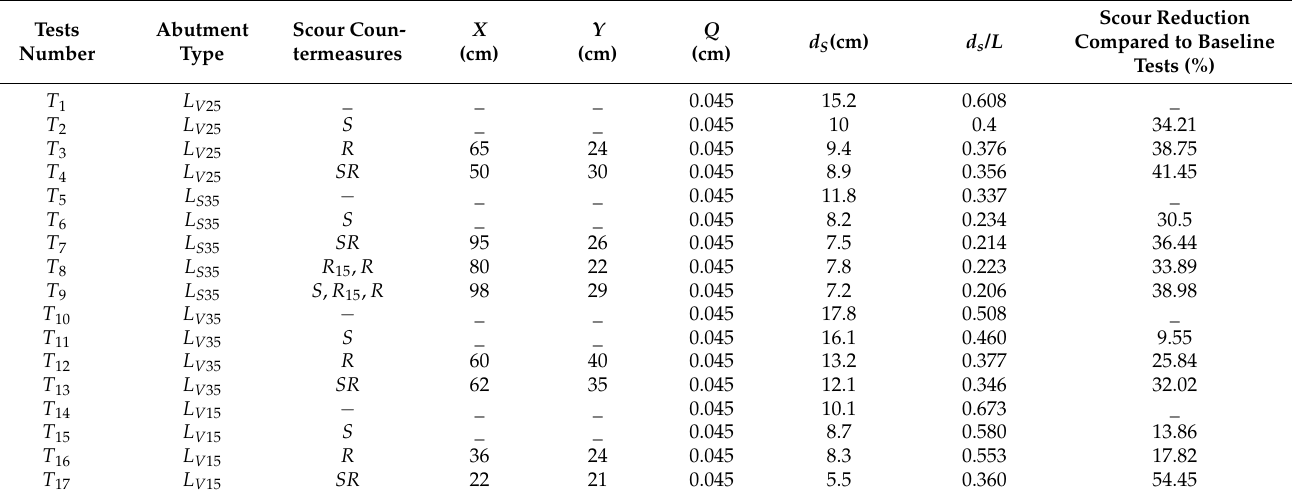
Table 3. Summary of results.